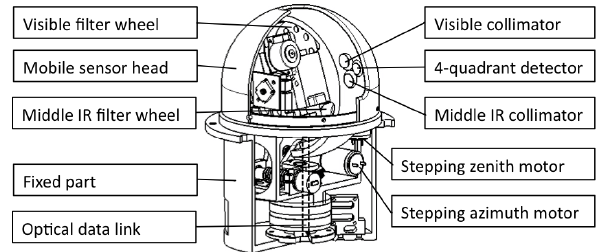
Fig. 1. PLASMA scheme.